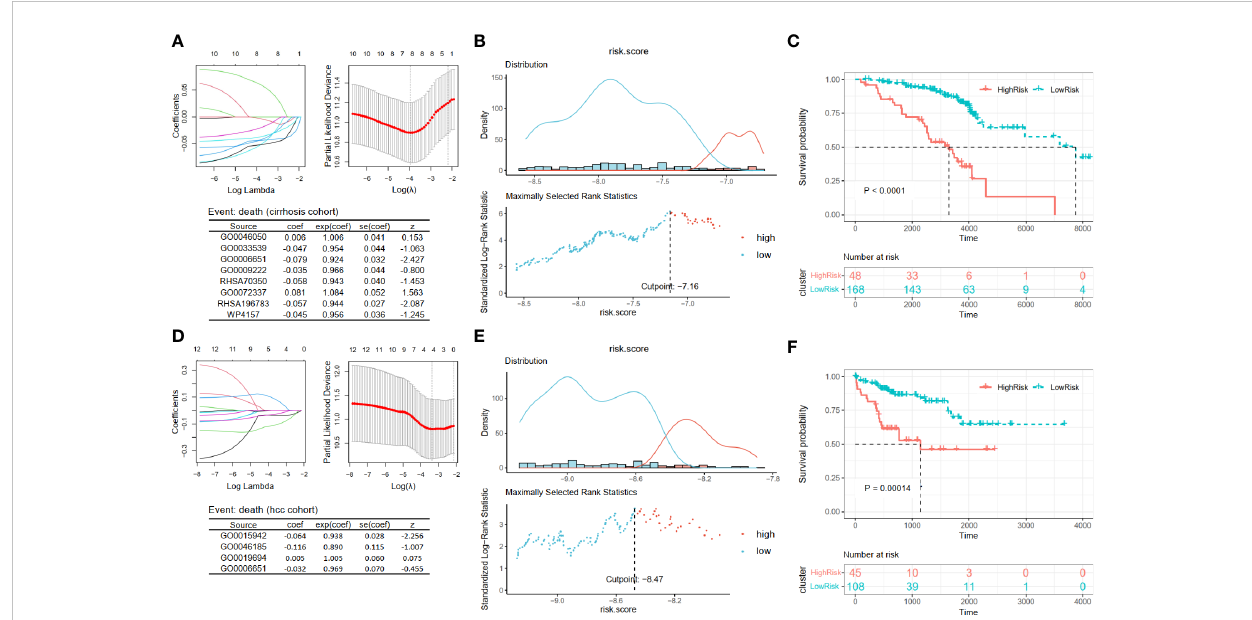
FIGURE 6 Construction and validation prognosis-related models. (A, D) The LASSO regression models were visualized. (B, E) According to the cut point obtained from maximally selected rank statistics, the patients were divided into two risk groups. (C, F) Kaplan – Meier plots of survival curve between high-risk and low-risk groups in two models. LASSO, least absolute shrinkage and selection